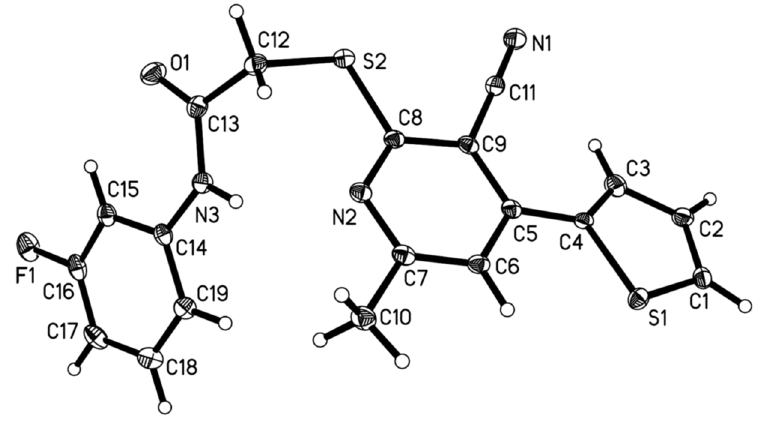
Figure 3. The single crystal structure of compound A (CCDC 2102104).